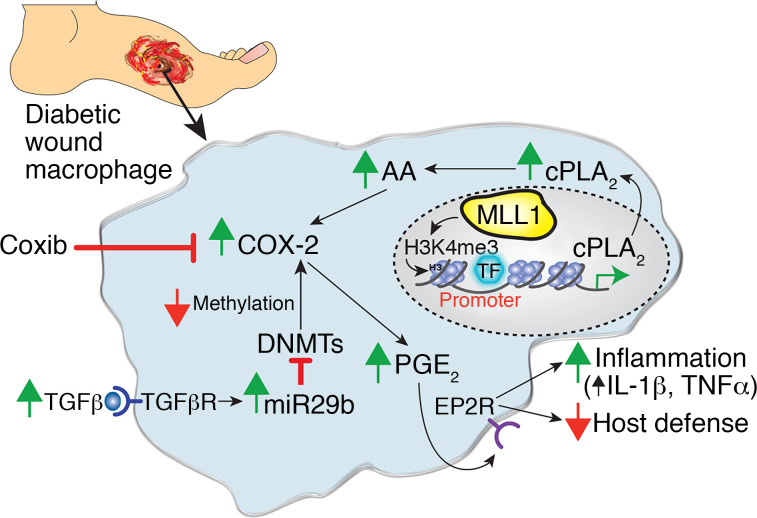
Schematic of PGE2 pathway regulation in normal and diabetic wound macrophage.